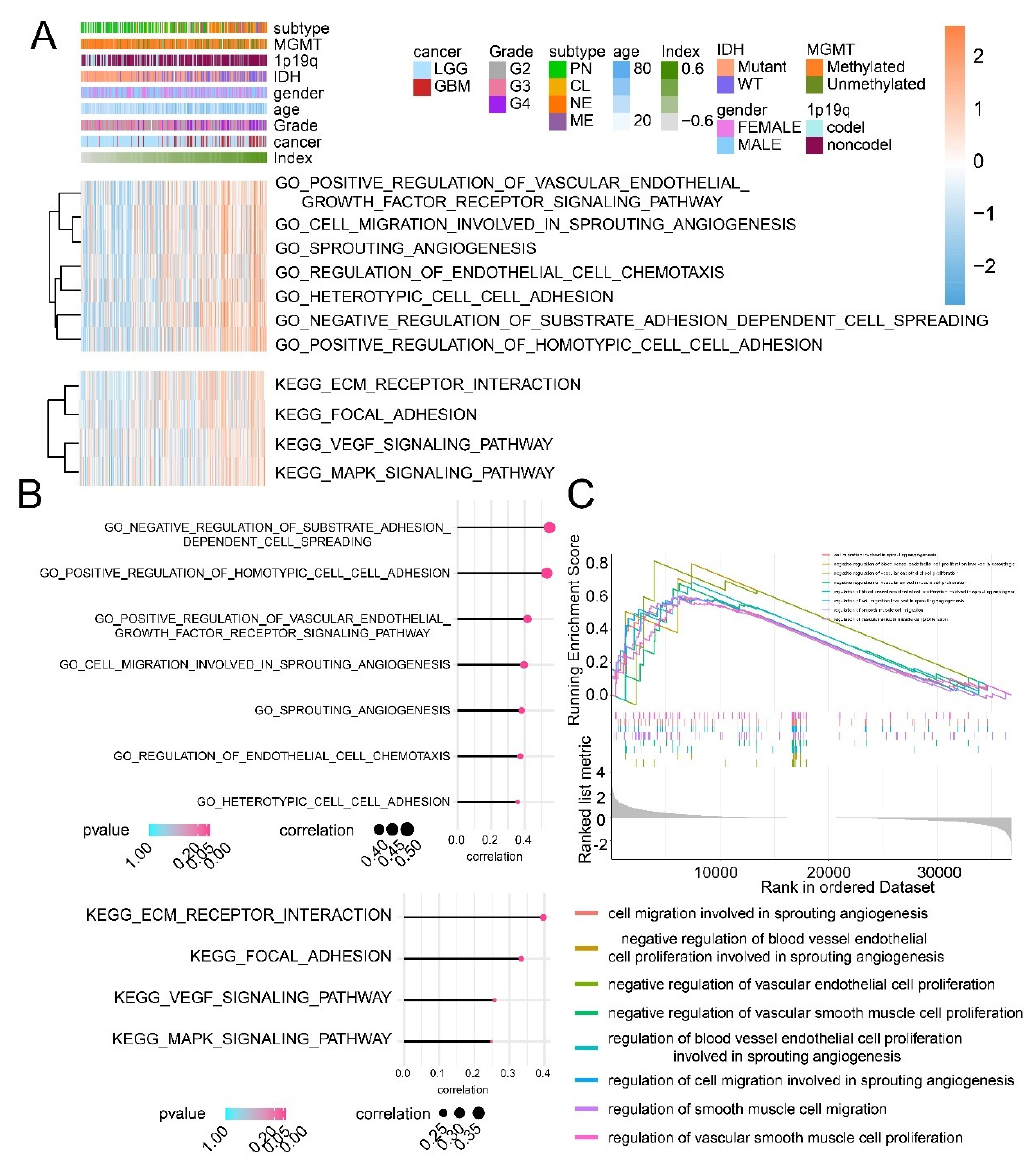
Figure 6. The GO/KEGG enrichment analysis and the GSEA analysis based on the CI model. ( A ) The relationship between CI and enrichment score of pathways from the GO/KEGG enrichment analysis. ( B ) The correlation between CI and pathways from the GO/KEGG enrichment analysis. ( C ) The GSEA analysis based on high and low CI samples.